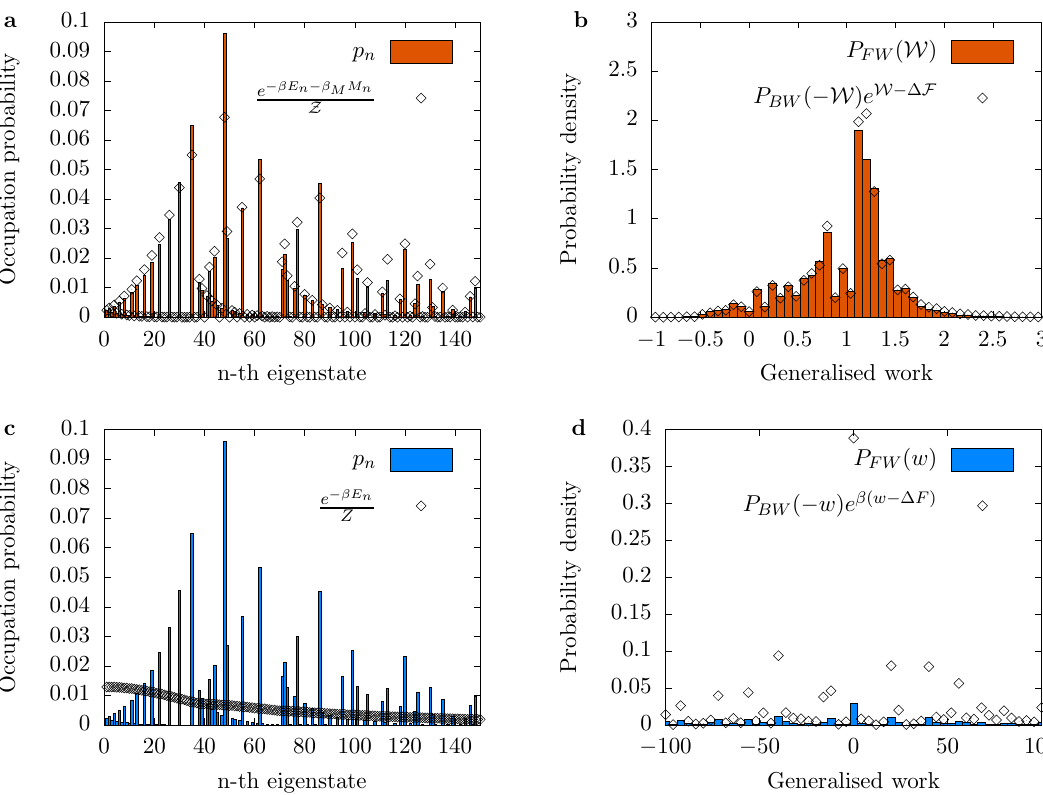
Figure 1: Panels (a) and (c) compare the numerical results for the occupation num- bers in the state after the forward quench (solid histograms) with the reference distributions (diamonds). In panel (a), the reference distribution is a GGE with β = 2.76 · 10 − 3 and β = 1.41 · 10 − 1 (values obtained from a least-square fit to the M values of 〈 ˆ H 〉 and 〈 ˆ M 〉 ). In panel (c), the reference distribution is a standard Gibbs with β = 6.02 · 10 − 3 (value obtained from a least-square fit to the value of 〈 ˆ H 〉 ). Pan- els (b) and (d) show the results for the (generalised version of) the Tasaki-Crooks theorem. Results for the forward distributions are displayed with solid histograms, and results for the backwards, together with the factors e W − ∆ F or e β ( w − ∆ F ) , with diamonds. Panel (b) refers to the GGE case, and panel (d) to the standard Gibbs